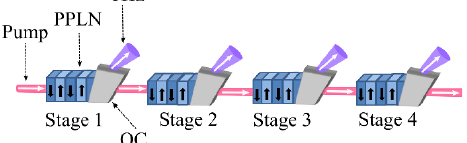
Fig. 1. Schematic illustration of the multi-stage system. QC represents the quartz